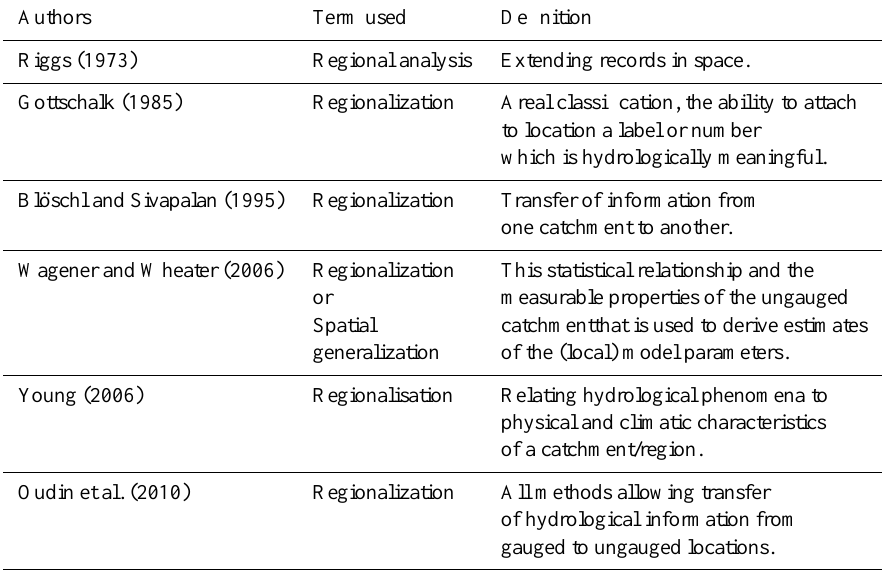
Table 1. Definition of regionalisation as it appears in the literature